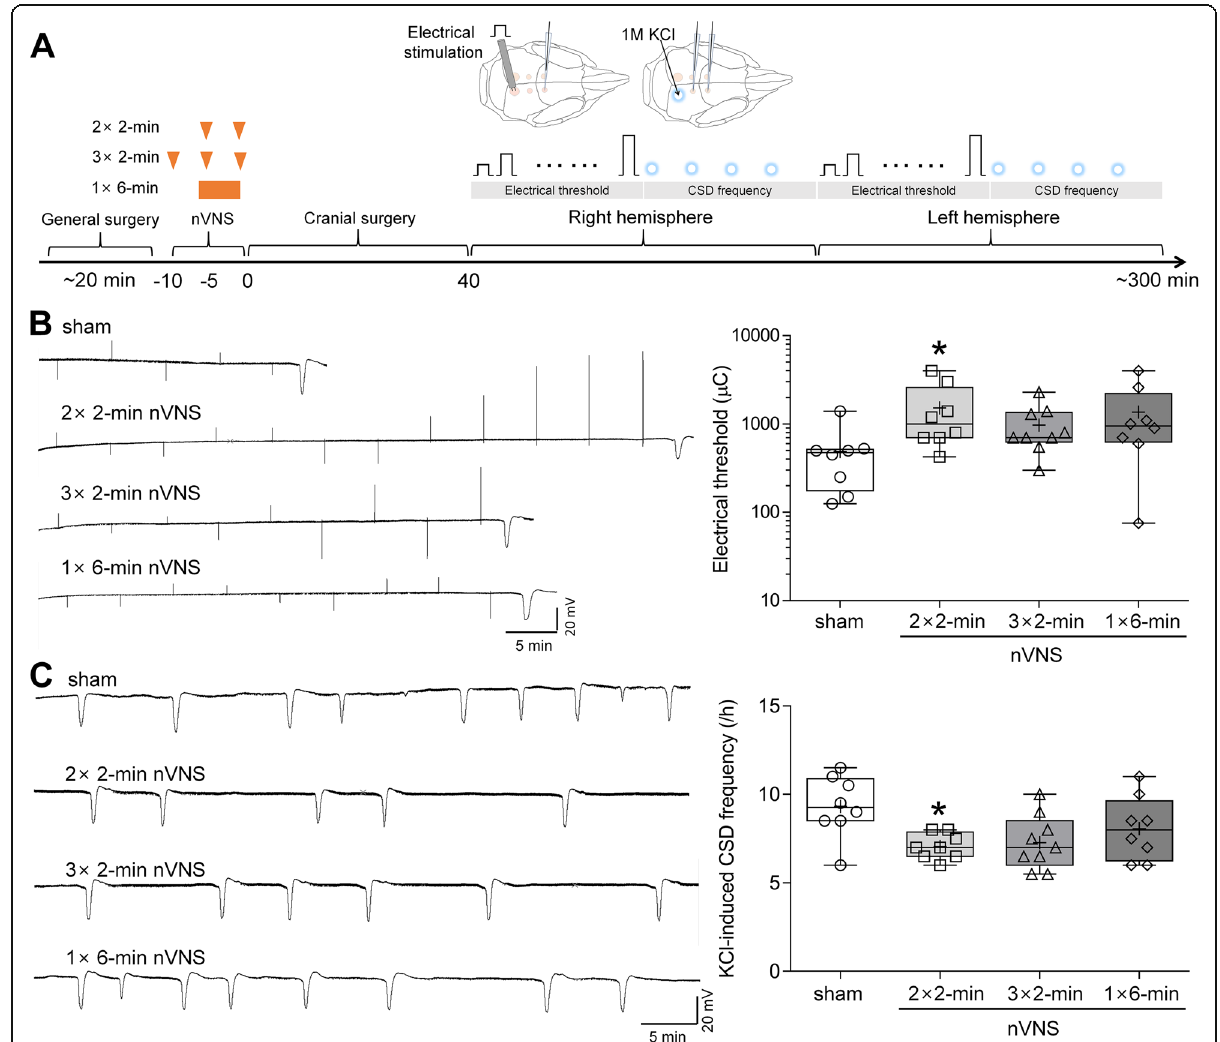
Fig. 2 Two 2-minute nVNS affords the most efficacious suppression of CSD. A Schematic diagram of dose-response paradigm of acute nVNS. A triangle indicates a 2-minute stimulation at medium intensity. B-C Representative intra-cortical microelectrode recordings and whisker – box plots show the effect of sham stimulation or noninvasive transcutaneous VNS at dose of 2 × 2-minute, 3 × 2-minute, and 1 × 6-min (11.4 V) on electrical threshold ( B ) and KCl (1 M)-evoked CSD frequency ( C ) in rats. Whisker – box plots show that 2 × 2-minute nVNS but not 3 × 2-minute, 1 × 6-min or sham stimulation significantly elevate electrical threshold and inhibit KCl-evoked CSD frequency in rats (whisker: full range; line: median; cross: mean; n =9 for 3 × 2-minute paradigm and n =8 for other groups; data are the mean of two hemispheres; * P= 0.0261 for electrical threshold, * P = 0.01 for CSD frequency, compared to sham group, Kruskal-Wallis test followed by post hoc Dunn ’ s multiple comparisons test). The lower CSD frequency stems from different anesthesia used in different experimental paradigms (barbiturate for amplitude-response; isoflurane+N 2 O for dose- response and chronic